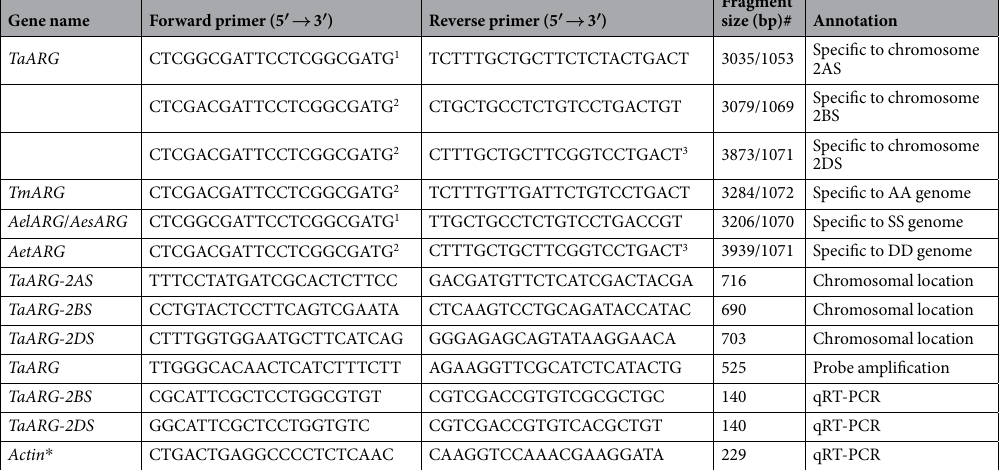
Table 1. Sequences of primer pairs used in this study. Primer sequences labeled with the same number have the same sequence. #The numbers before and after the slashes represent the lengths of the gDNA and cDNA sequences, respectively. * GenBank Accession number: AB181991.